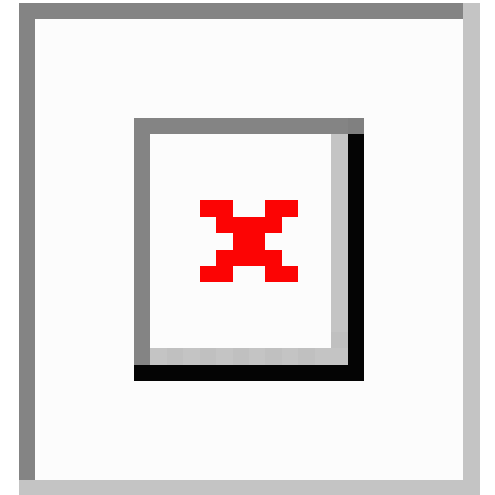
Figure 7. Equation shows treatment two appears more